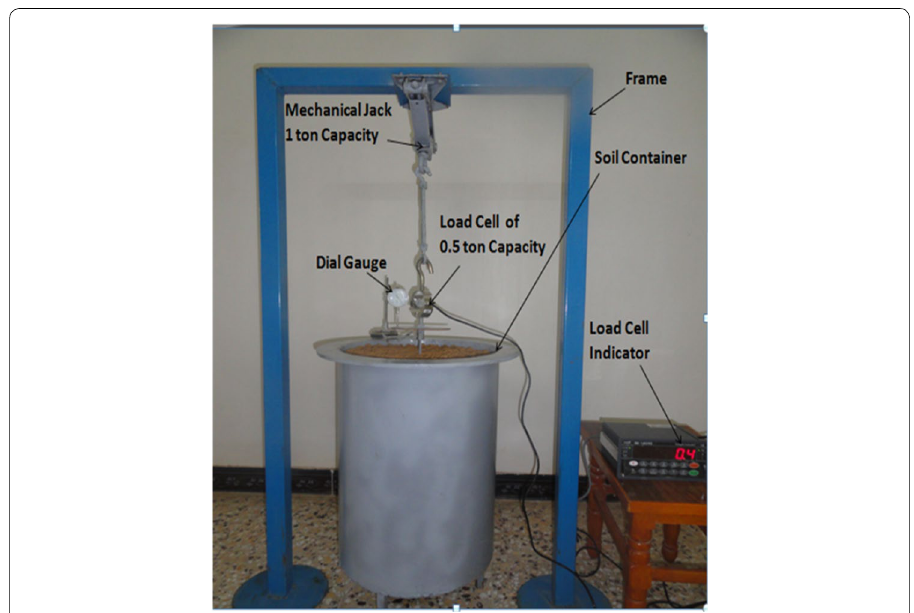
Fig. 9 Model pile pullout test system during